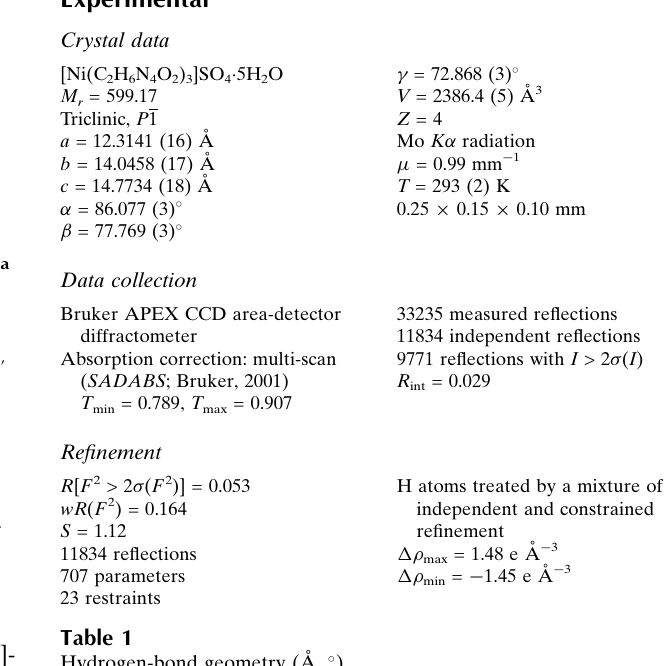
Hydrogen-bond geometry (A˚ , (cid:2) ). D —H (cid:1)(cid:1)(cid:1)